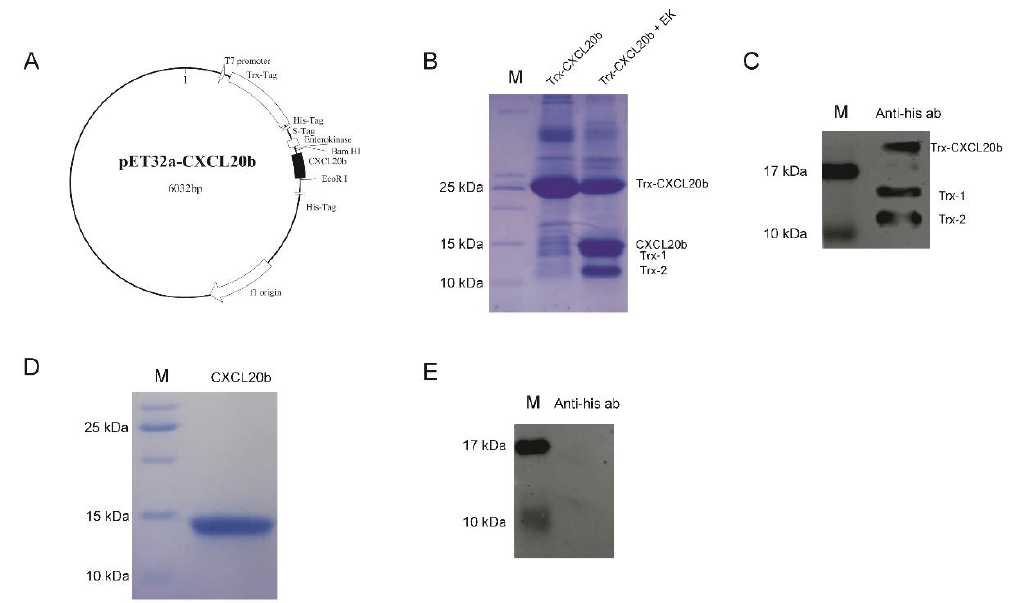
Figure 1. Producing of recombinant grass carp CXCL20b. ( A ) Plasmid map of recombinant